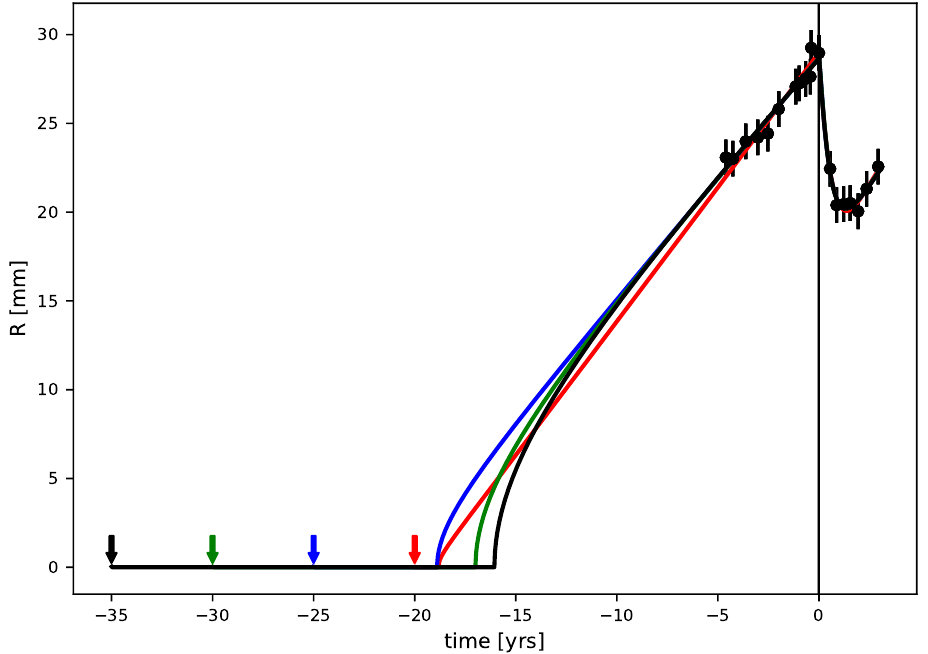
Figure 4. Full evolution of the radius of the four models corresponding to the bottom points ( ∆ χ 2 < 1) from Figure 3a. The origin time is fixed at RT, and the starting time of the tumor is indicated by colored arrows. All of the models give similar χ 2 values with respect to the